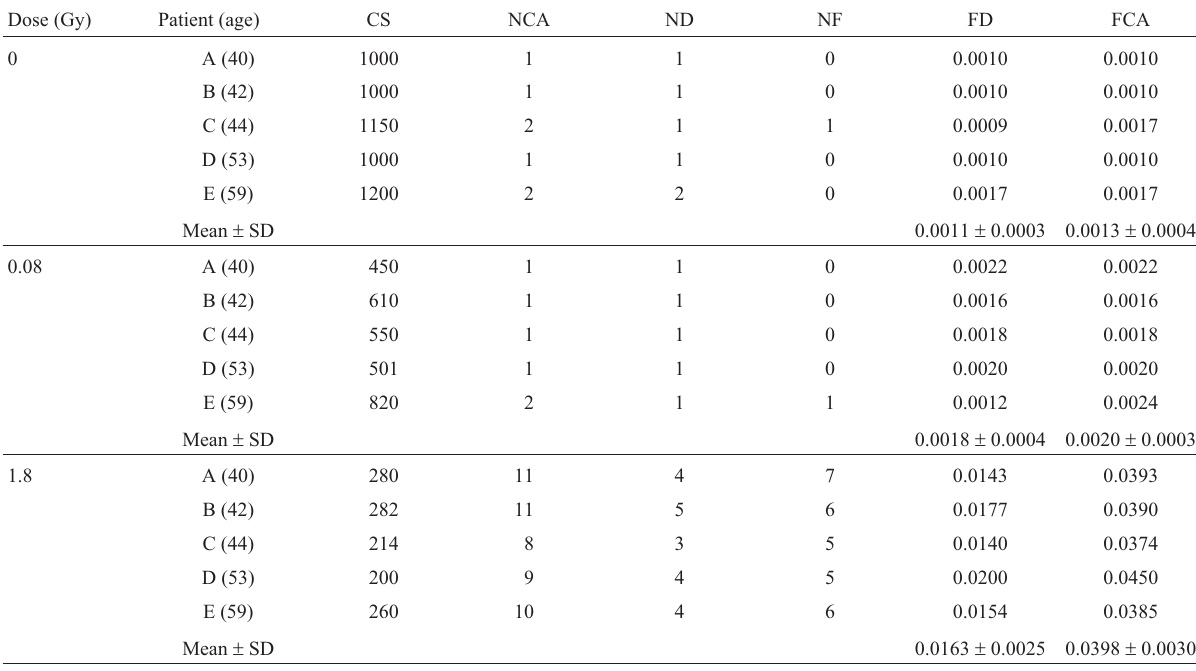
Table 1 - Distribution of unstable CA (dicentrics and fragments) for absorbed doses of 0 Gy (background), 0.08 Gy and 1.8 Gy. Dose